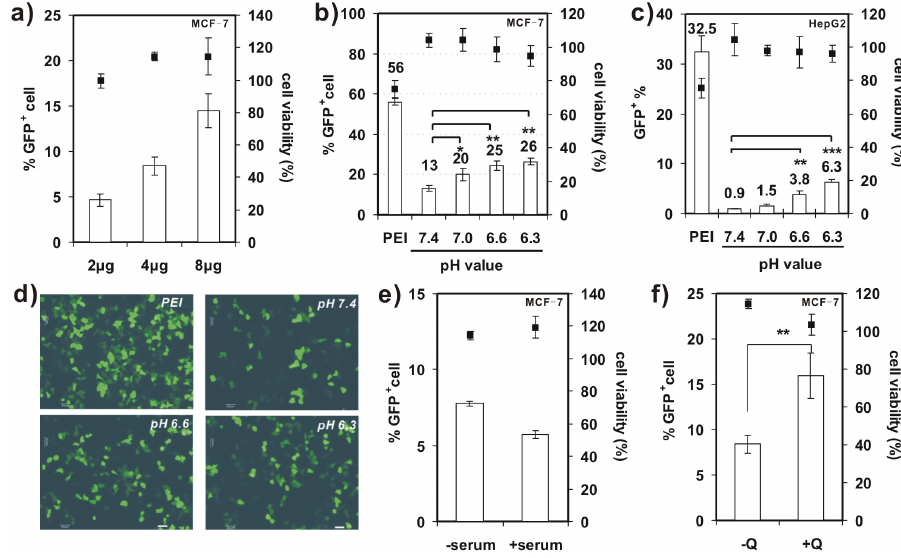
Figure 5. ( a ) Transfection efficiency and cytotoxicity of 4-arm PEG-SSPHIS in MCF-7 cells as a function of DNA dose (2–8 μ g); ( b , c ) Transfection efficiency and cytotoxicity of 4-arm PEG-SSPHIS using 8 μ g DNA against MCF-7 ( b ) and HepG2 ( c ) cells as a function of pH values. The cells were detected at 48 h after 4 h transfection with the polyplexes of 4-arm PEG-SSPHIS in the absence of serum and 44 h-post transfection. Polyplexes of 25 kDa PEI at the mass ratio of 1/1 was used as a control. * p < 0.05, ** p < 0.01, *** p < 0.001; ( d ) Typical images of GFP + MCF-7 cells after transfection at varying pH values (scale bar: 50 nm); ( e ) Effect of FBS on the transfection efficiency of 4-arm PEG-SSPHIS with 4 μ g of DNA; ( f ) Effect of 100 μ M chloroquine (CQ) on the transfection efficiency of 4-arm PEG-SSPHIS with 4 μ g of DNA. ** p < 0.01. All